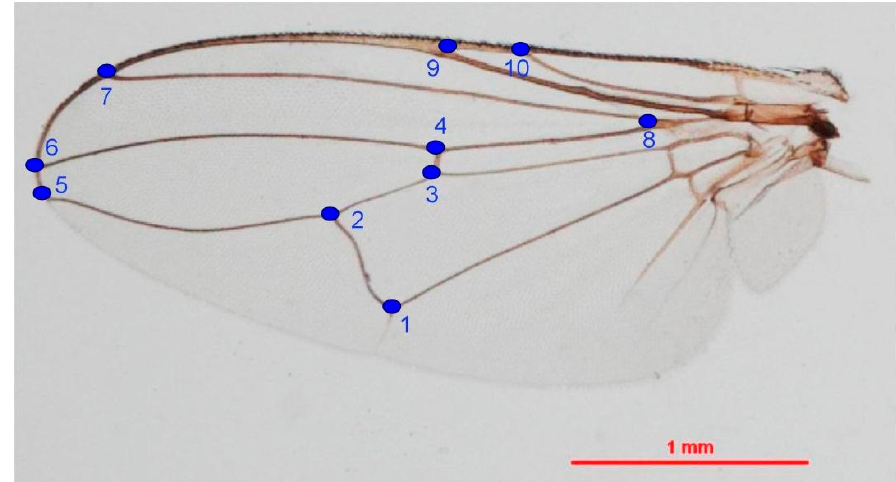
Figure 2. Ten landmarks digitised on wings of Haematobosca aberrans Pont, Duvallet & Changbunjong, 2020.